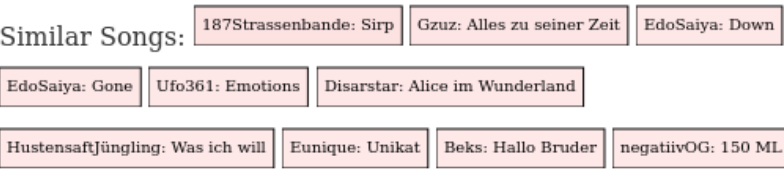
Figure 4. The most similar English songs ( a ) and the artist profile of the German rap group BHZ ( b